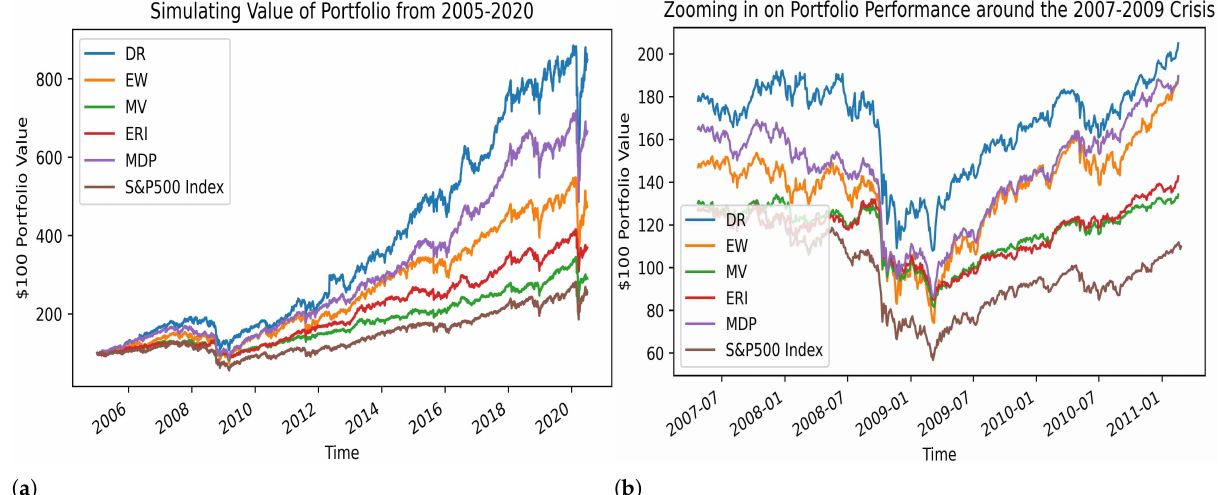
Figure 3. The values of portfolios of 361 stocks under the strategies of DR, EW, MV, ERI, and MDP, and the values of S&P 500 index. The initial value for each portfolio is set as $100. ( a ) The entire backtest period 2005–2020; ( b ) the financial crisis of 2007–2009 period.